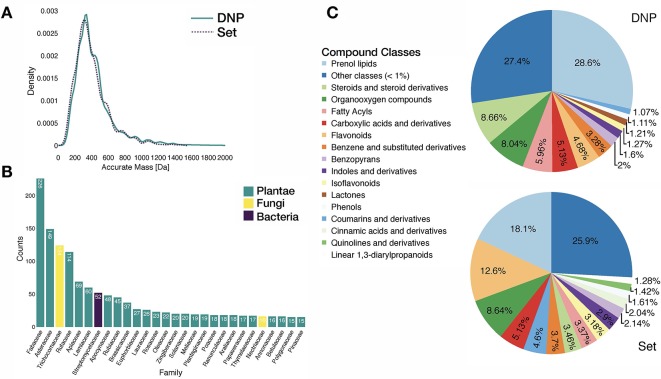
Characteristics of the benchmarking dataset. (A) Comparative distribution of accurate masses of entries in the DNP and in the benchmarking dataset. (B) Distribution of biological sources of entries in the benchmarking dataset at the family taxa level (cutoff at 15 entries per family). (C) Comparative distribution of chemical classes (ClassyFire Class level) within the DNP and the benchmarking set.